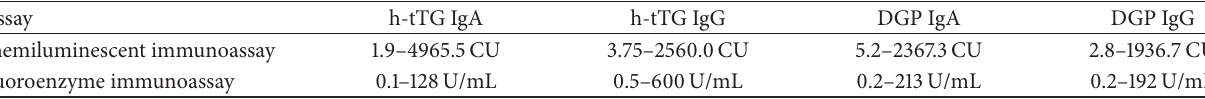
Table 1: Analytical measuring range for celiac disease